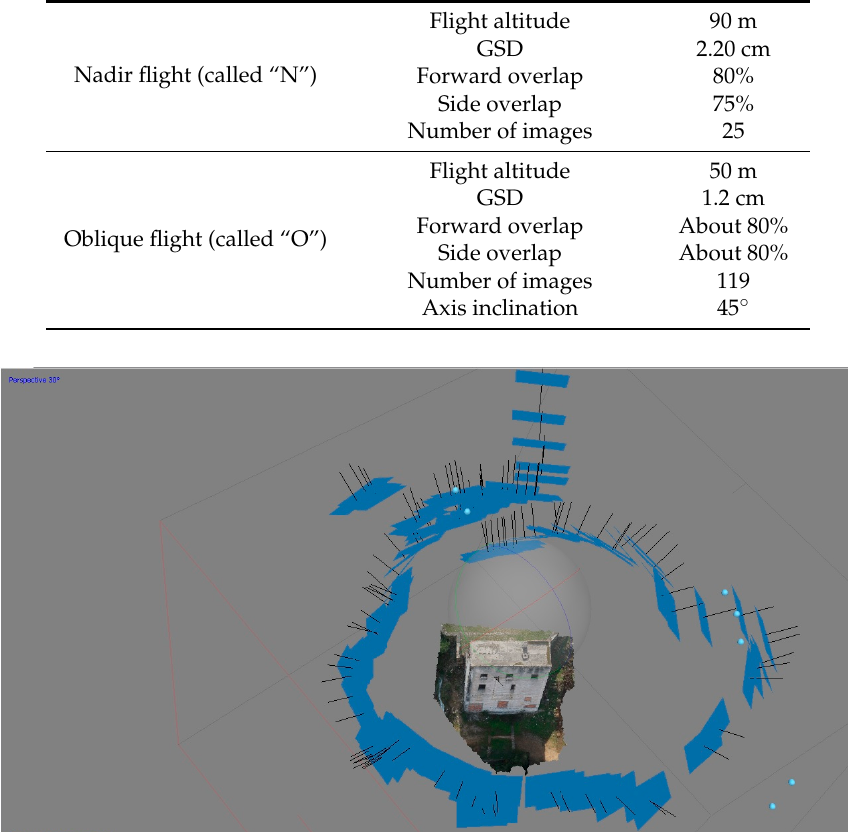
Figure 17. Oblique flight.